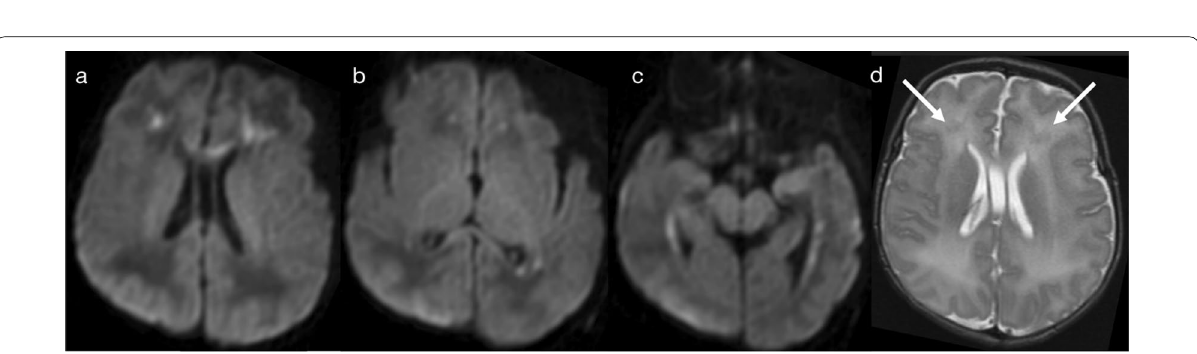
Fig. 3 Restricted diffusion in supratentorial white matter—limited (Pattern 1B). 8‑day‑old term infant with raised inflammatory markers and vomiting (no seizures). CSF was positive for enterovirus. DWI ( a – c ) demonstrated scattered foci of restricted diffusion involving deep and periventricular white matter, best seen in the frontal lobes ( a ) and temporal lobes ( c ). On T2‑weighted imaging ( d ), corresponding foci of low signal intensity were difficult to appreciate